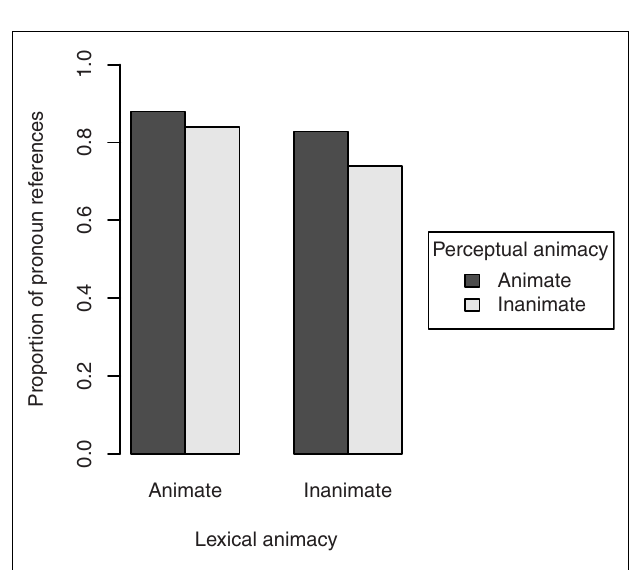
FIGURE 4 | Proportion of pronoun references to the target in the description of the transitive action in Experiment 1, by its lexical and perceptual